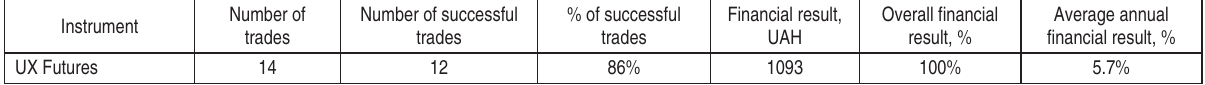
Table 7. Trading simulation results for the Turn of the Year Effect (PFTS index)